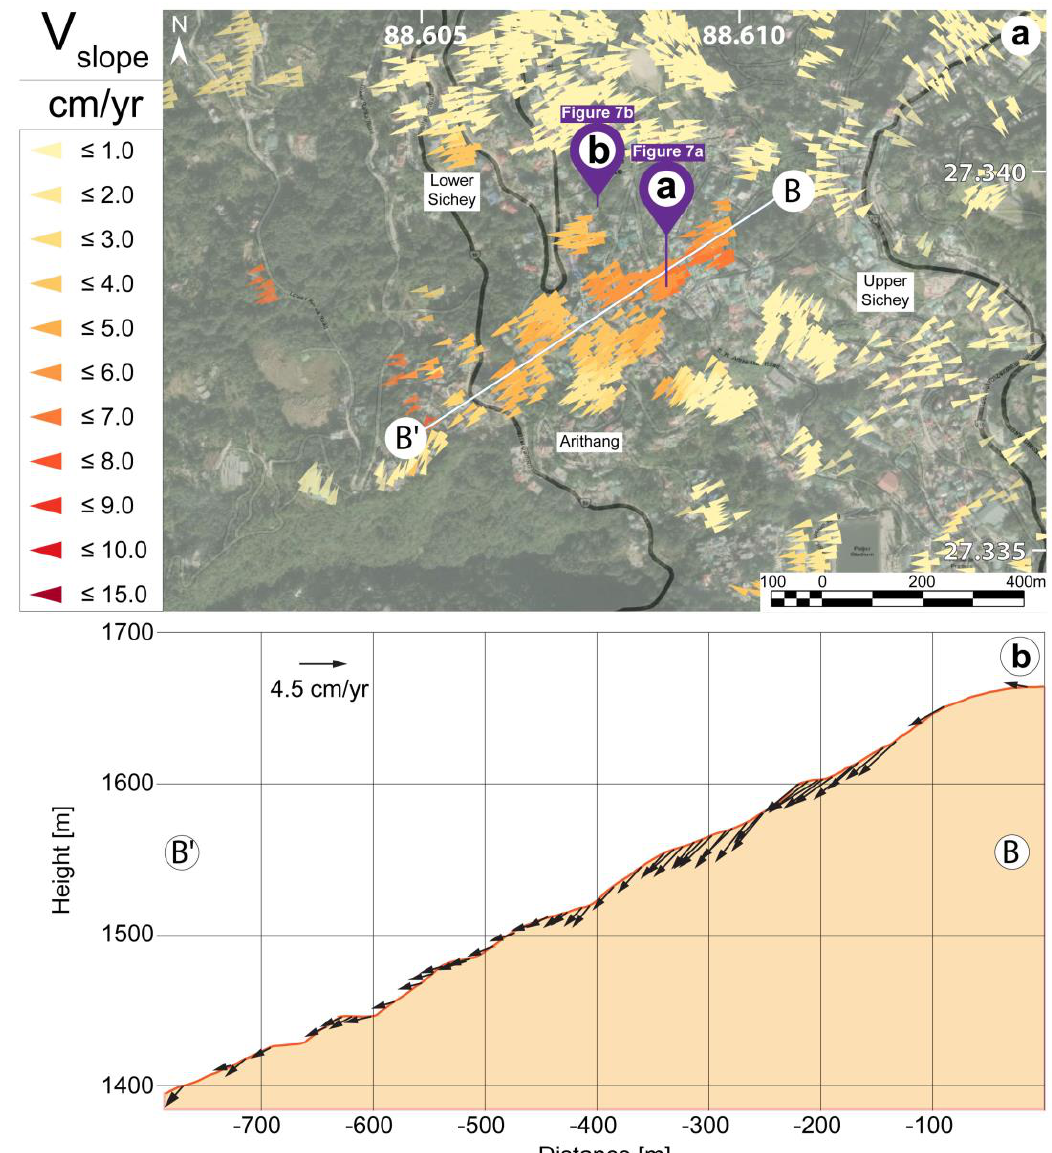
Figure 6. ( a ) InSAR velocity field in Upper and Lower Sichey with a profile line drawn towards the southwest along the Upper Sichey landslide. ( b ) Displacements along the profile. BB ′ in Upper Sichey.